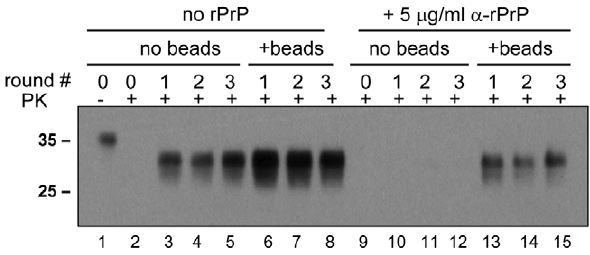
Figure 5. Beads improve the amplification efficiency of SSLOW. SSLOW scrapie brain material was diluted 10 3 -fold (lanes 1–8) or 10 4 - fold (lanes 9–15) into 10% NBH, subjected to serial PMCA in the absence or presence of 3 small beads, as indicated, and digested with PK. Each PMCA round consisted of 48 cycles; the material amplified in each round was diluted 10-fold into 10% NBH for the next PMCA round. Undigested 10% NBH (lane 1) loaded at 1/10 th the amount of the digested samples is provided as a reference.